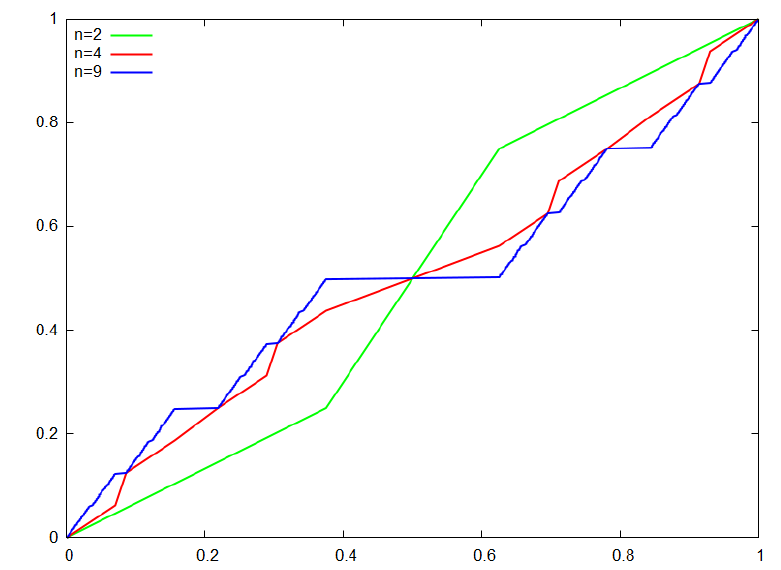
Figure 1. Approximations of the Smith–Volterra–Cantor (SVC)